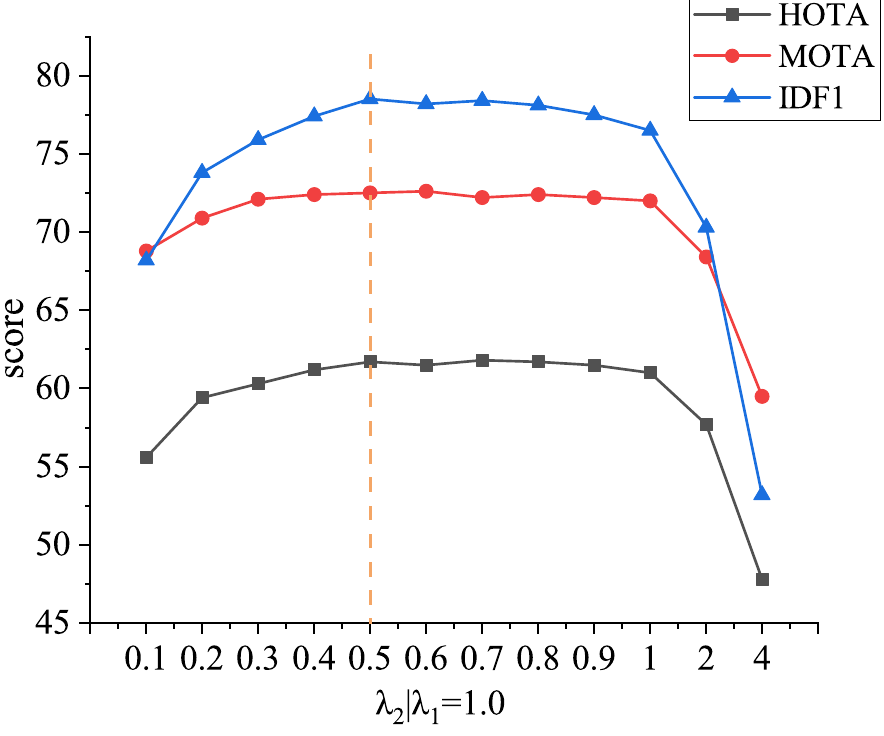
Figure 5. Experiments for hyperparameters in EG matrix in MOT17-half val. The blue, red and black lines represent IDF1, MOTA and HOTA indicators, respectively. The parameters selected in the paper are shown by the dotted line.